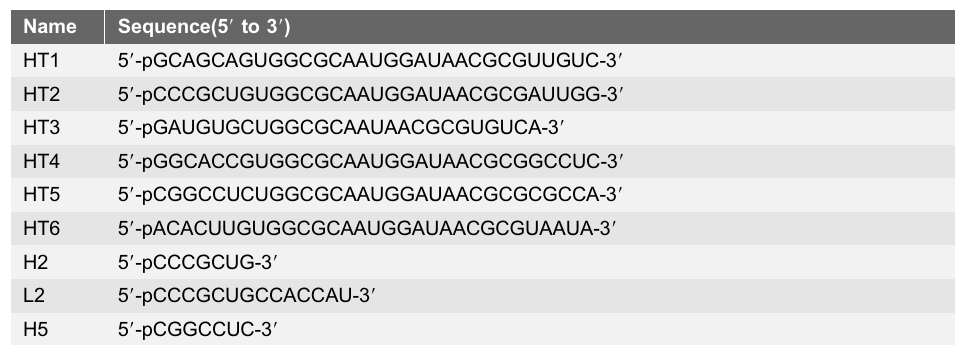
Table1. Sequence of